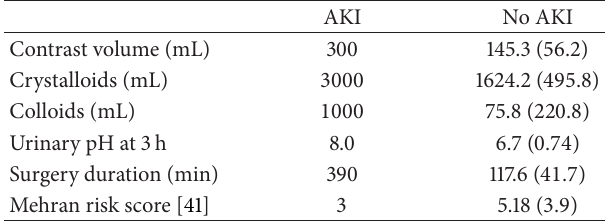
Table5:Baselinecharacteristicsbetweenthepatientwhodeveloped AKI versus the patients who did